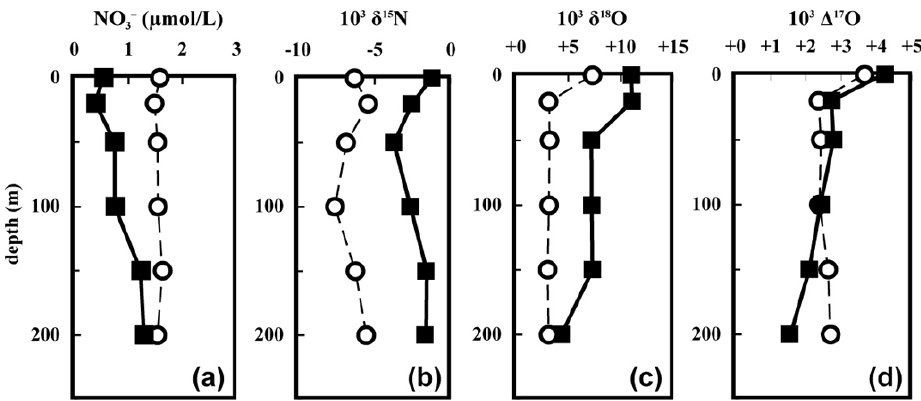
Fig. 4. Vertical distribution of concentration (a) , δ 15 N (b) , δ 18 O (c) , and 1 17 O (d) of nitrate at Lake Mashu in June (white circle) and August (black square)